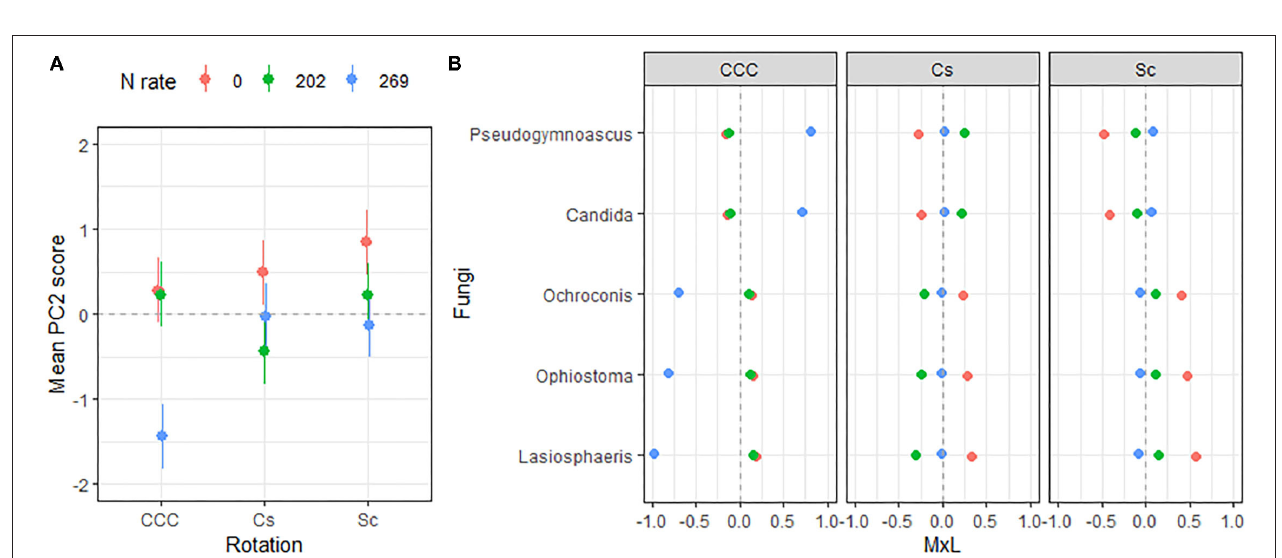
FIGURE 3 | (A) Mean value of the bacterial PC3 scores for each level of N fertilization with their standard errors (as whiskers). ( B) Contribution of each indicator genera to the PC mean value (MxL) for each level of N fertilization: 0kg N/ha (pale red), 202kg N/ha (pale green), and 269kg N/ha (pale blue).